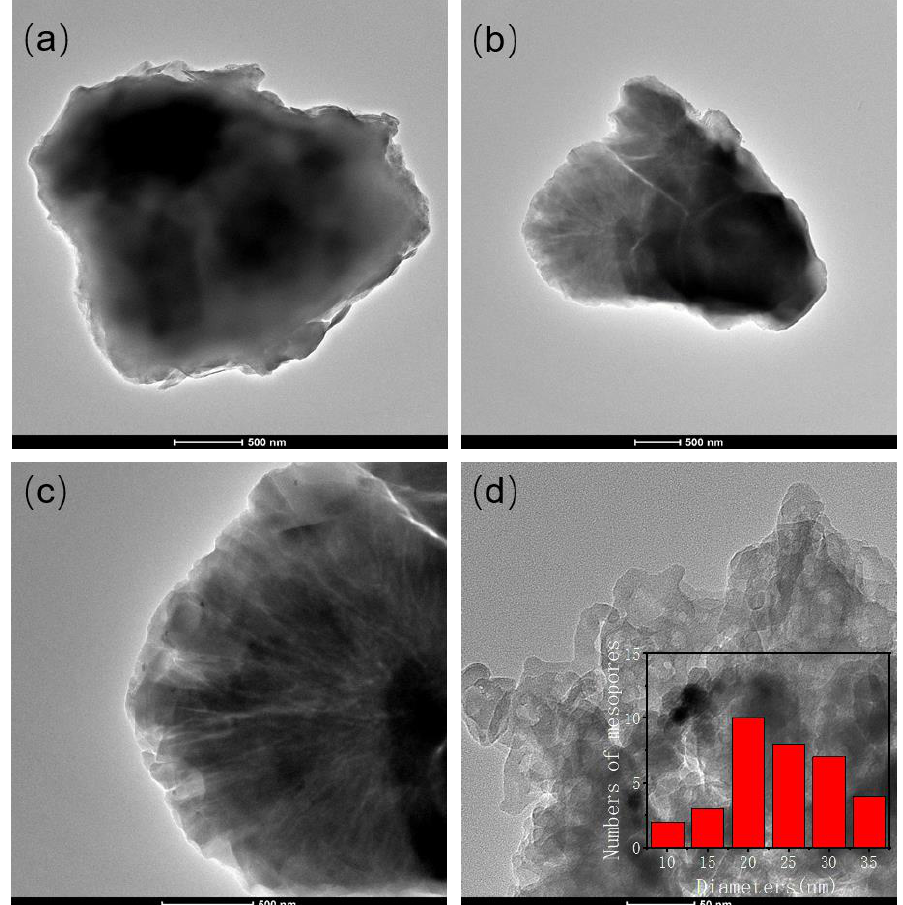
Figure 7. The TEM images of different types of ZSM-5. ( a ) Z–100, ( b ) Z–100–M, ( c ) Z–100–M under a higher magnification, and ( d ) high-resolution TEM images of Z–100–M.